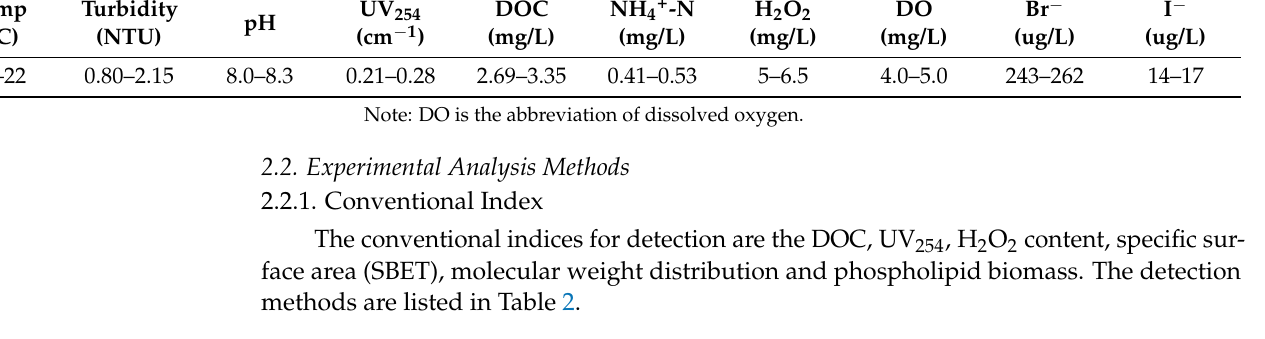
Table 2. Conventional indexes detecting methods or